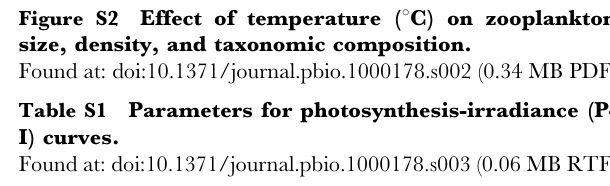
( m M) and temperature ( u C) in Bogue Sound, North Carolina. Figure S2 Effect of temperature ( u C) on zooplankton size, density, and taxonomic composition. Found at: doi:10.1371/journal.pbio.1000178.s002 (0.34 MB PDF) Table S1 Parameters for photosynthesis-irradiance (P- I) curves. Found at: doi:10.1371/journal.pbio.1000178.s003 (0.06 MB RTF) Text S1 Additional methodological